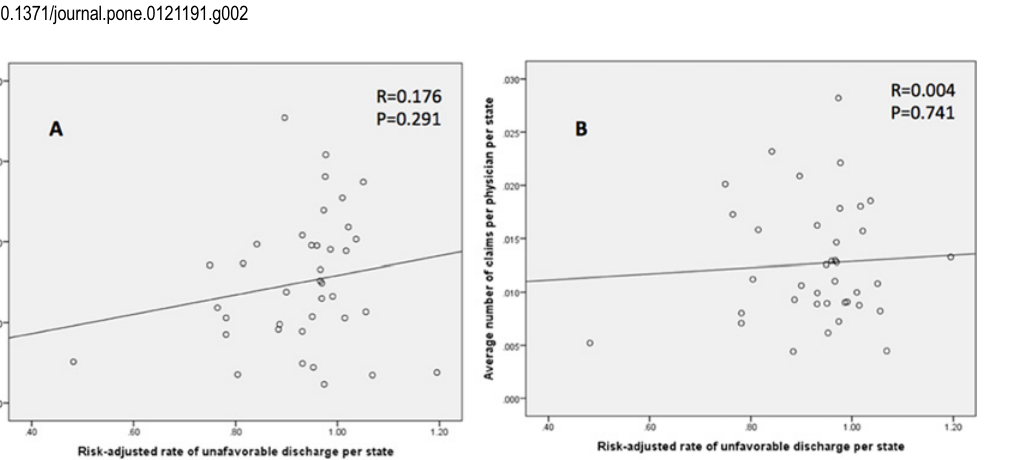
Fig 2. Scatter plot demonstrating the correlation of average state-level mortality for cranial neurosurgical procedures and average size (ln- transformed) (A) and number (B) of paid claims per physician per state.